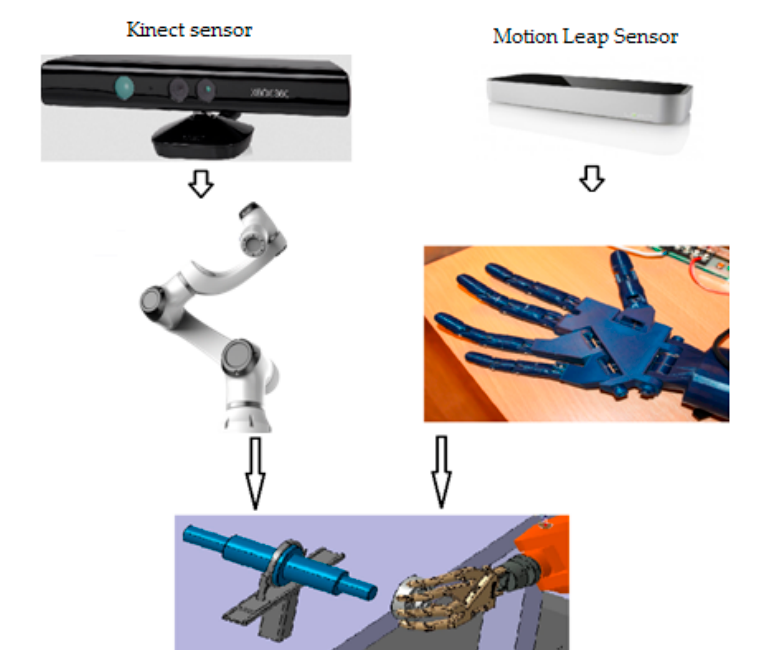
Figure 12. The shaft is stored in a box.